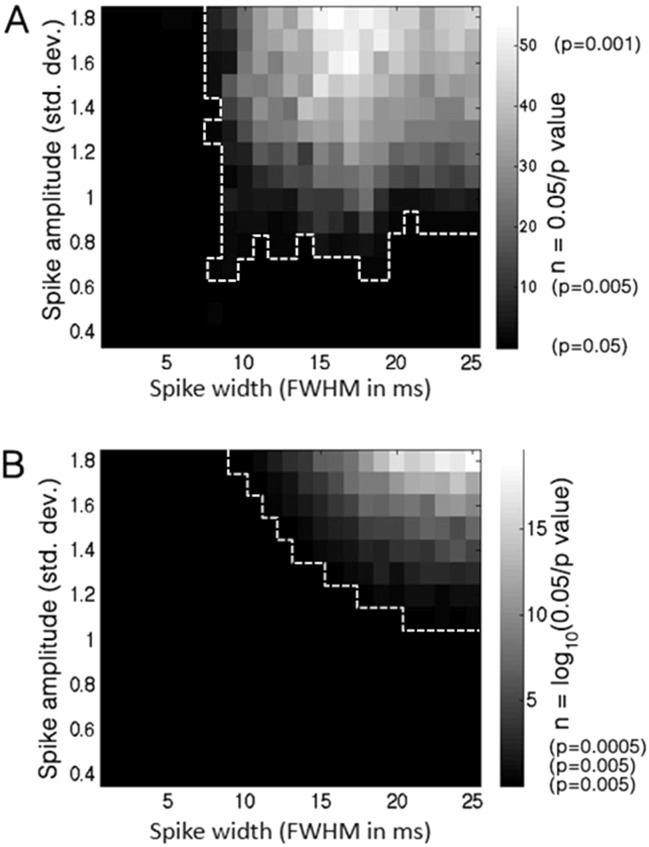
Statistical significance of phase-amplitude and phase-phase coupling for low-amplitude transients.A, Each pixel in the image represents the average p-value, across 100 repetitions, for a phase-amplitude CFC effect driven by adding a Gaussian spike train (inter-spike interval: 100 ms) of the given amplitude and width, to a background EEG signal featuring no initial CFC. The color scale corresponds not to the actual p-value, but to n = 0.05/p, i.e. the number of Bonferroni multiple-comparisons the effect “survives”, resulting in a simple linear scale of significance. The white outline indicates the cluster of significant pixels (n> = 1). Importantly, note that significant CFC occurs even for very low-amplitude transients (under 1 standard deviation). It can also be seen that the magnitude of CFC depends on the width of the transient waveform: very narrow transients do not contain enough energy to drive the phase of the slow-frequency component, while wide transients contain a weaker high-frequency component. B, Significance of phase-phase coupling between 10Hz and 20Hz is shown for the same range of transient amplitudes and widths. Since a parametric significance test was used, p-value tended to be very small and so the logarithmic scale n = log10(0.05/p) was used (such that n = 0 corresponds to p = 0.05, n = 1 to p = 0.005, etc.). White border indicates area where p<0.05. Note that the area indicated as significant in this analysis does not fully overlap that of the phase-amplitude coupling analysis (Fig 7A).